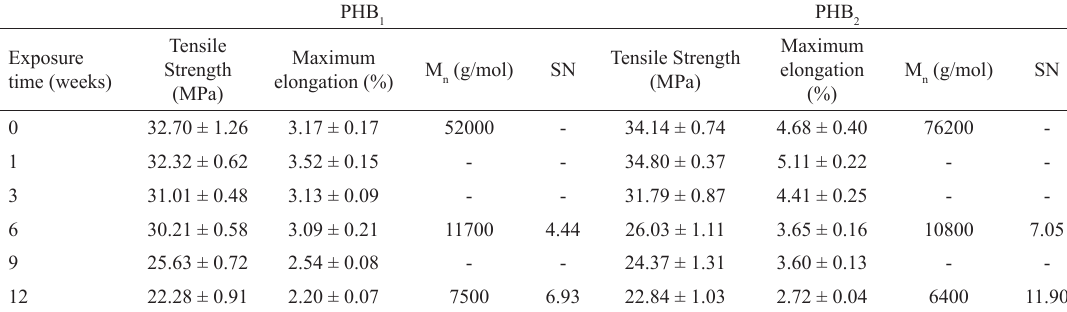
and PHB before and after exposure to UV radiation. 1 2 PHB 1